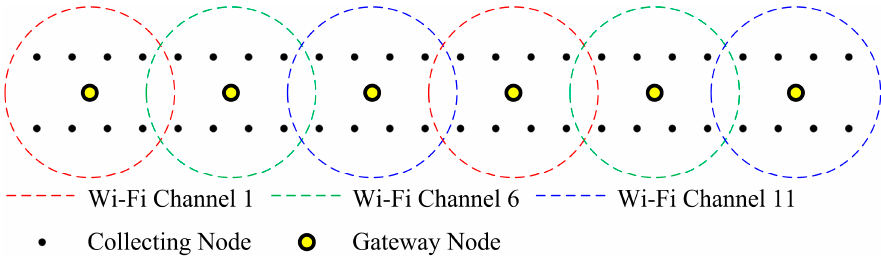
Figure 5. Coverage distribution of Wi-Fi access points (Aps).